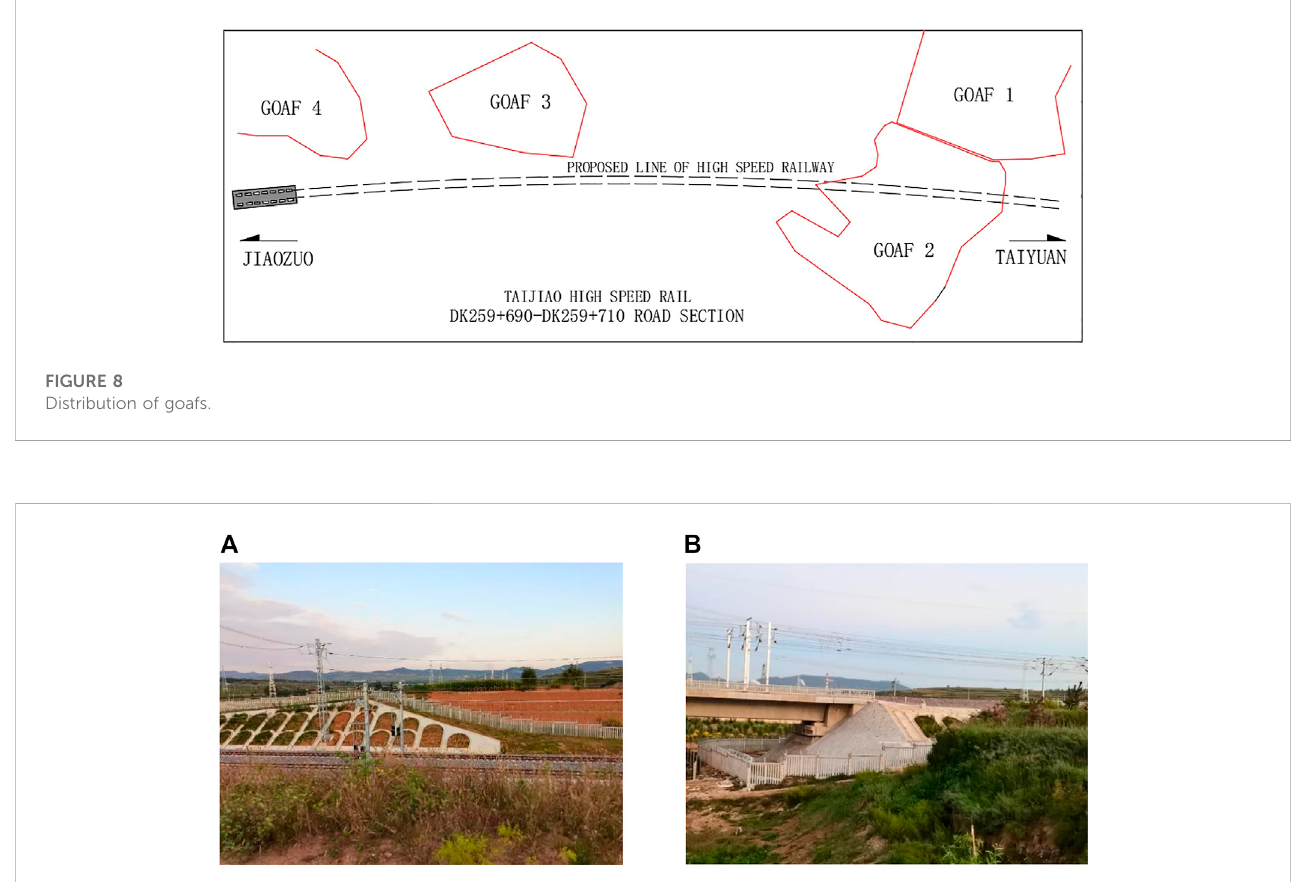
FIGURE 9 High-speed railway and topography of goaf sites. (A) Cutting segment of high-speed railway lines. (B) Bridge, embankment, and the river of high-speed railway lines.